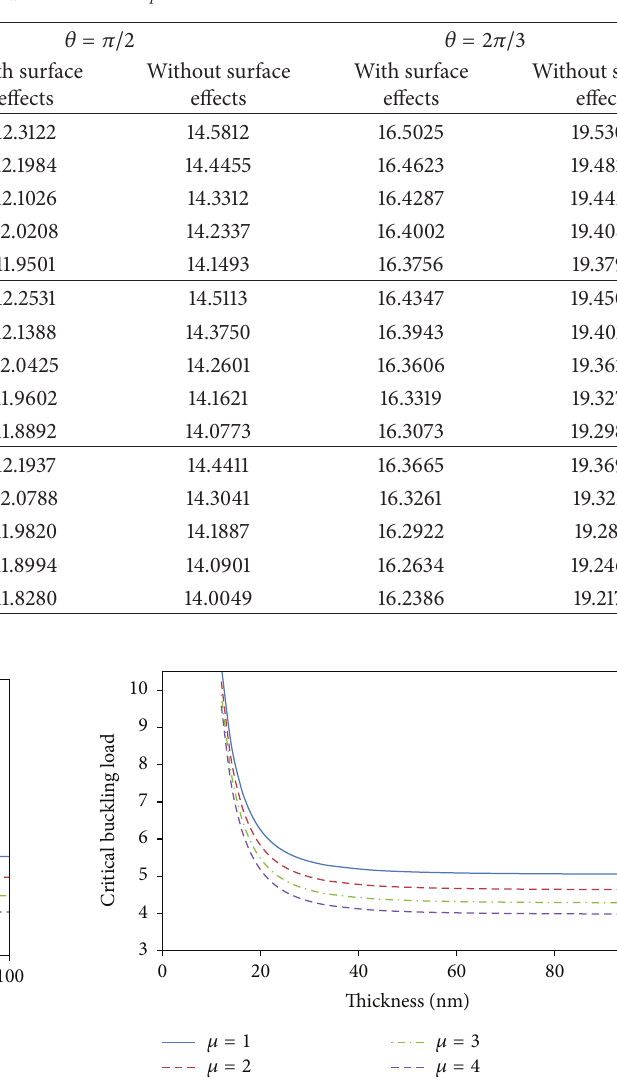
Table 3: Comparison of the dimensionless fundamental natural frequencies of circular curved nanobeam with and without surface effects with various temperature changes and nonlocality 𝑅 = 20nm, 𝐾 𝑤 = 10 10 , and 𝐾 𝑝 = 10 −6 .